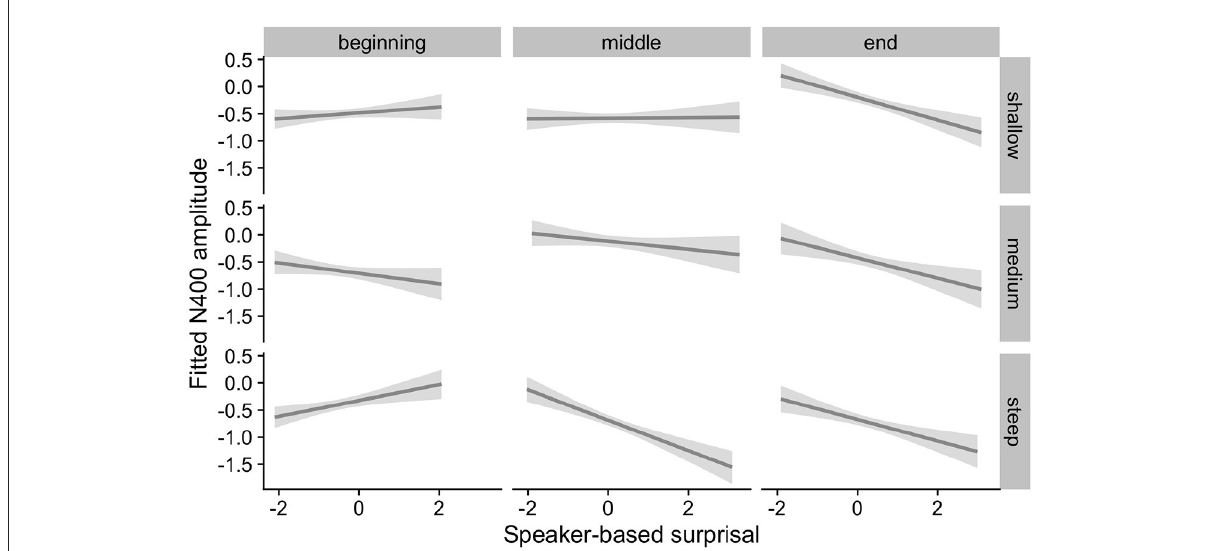
FIGURE4 Effect of aperiodic (1/f) slope on changes in the relationship between speaker-based surprisal (z-transformed) and N400 amplitude over the course of Experiment 1. The figure visualizes partial effects as calculated using the remef package, adjusted for prestimulus amplitude, canonicity and frequency. Note that position in the experiment (operationalised via epoch in the statistical model) is trichotomised (into beginning, middle, end) for visualization purposes only; epoch was included in the model as a continuous predictor. The same holds for 1/f slope, which is trichotomised into steep, medium and shallow for visualization purposes but was entered into the statistical model as a continuous predictor. Shaded areas indicate 95% confidence intervals.